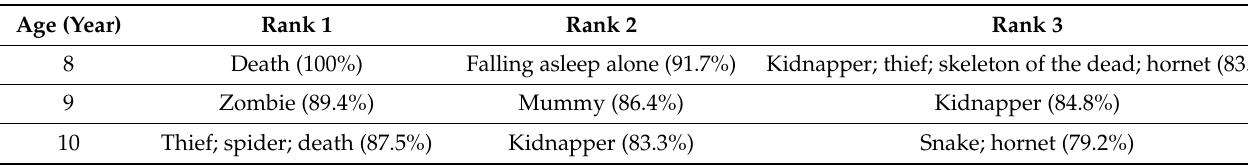
Table 6. Ranking of fear objects for different